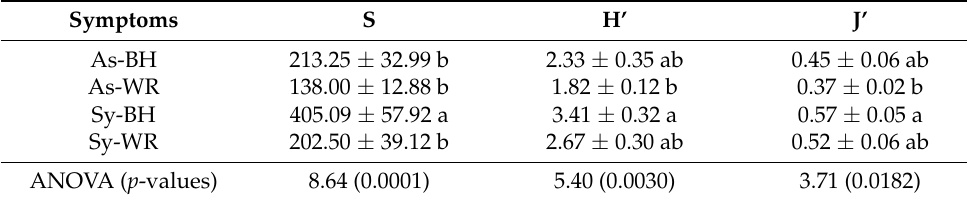
Table 1. Alpha-diversity estimation of the fungal community resulting from the culture- independent analysis of 48 wood samples.